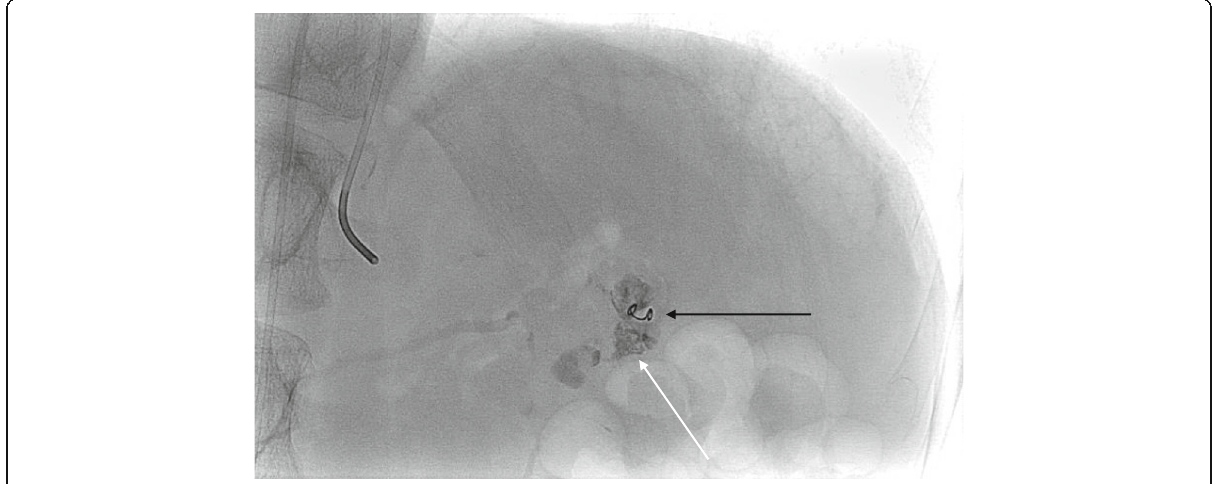
Fig. 3 Coil embolization by 2 × 20 mm HILAL Microcoil (black arrow) and proper distribution of tissue adhesive (white